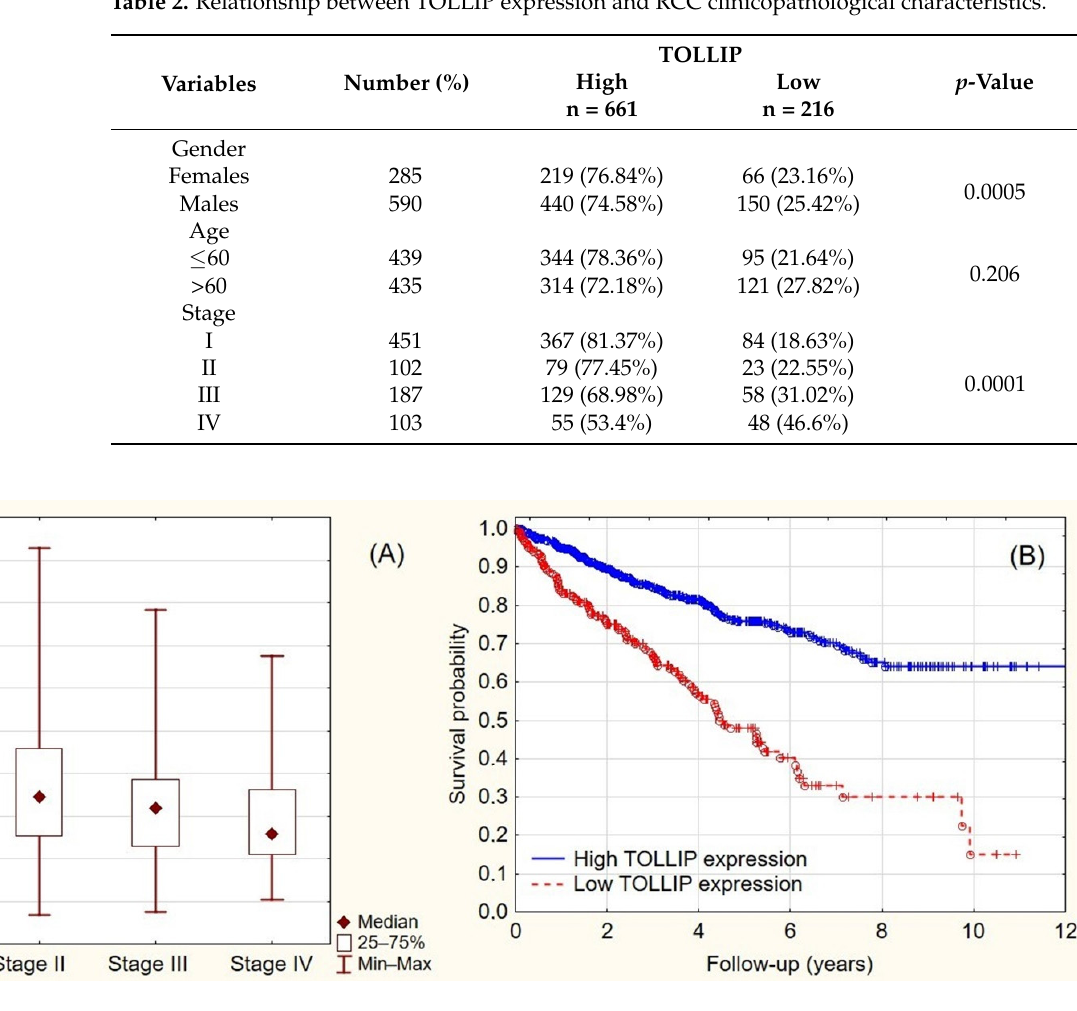
Table 3. Correlations between the expression of autophagy-associated genes and TOLLIP [16–32].